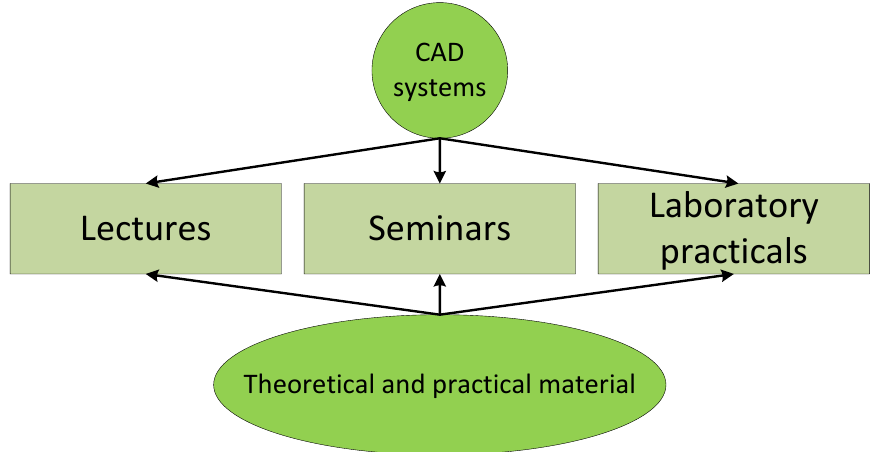
Fig. 3. Suggested approach of using CAD systems in training of the specialists in analogue